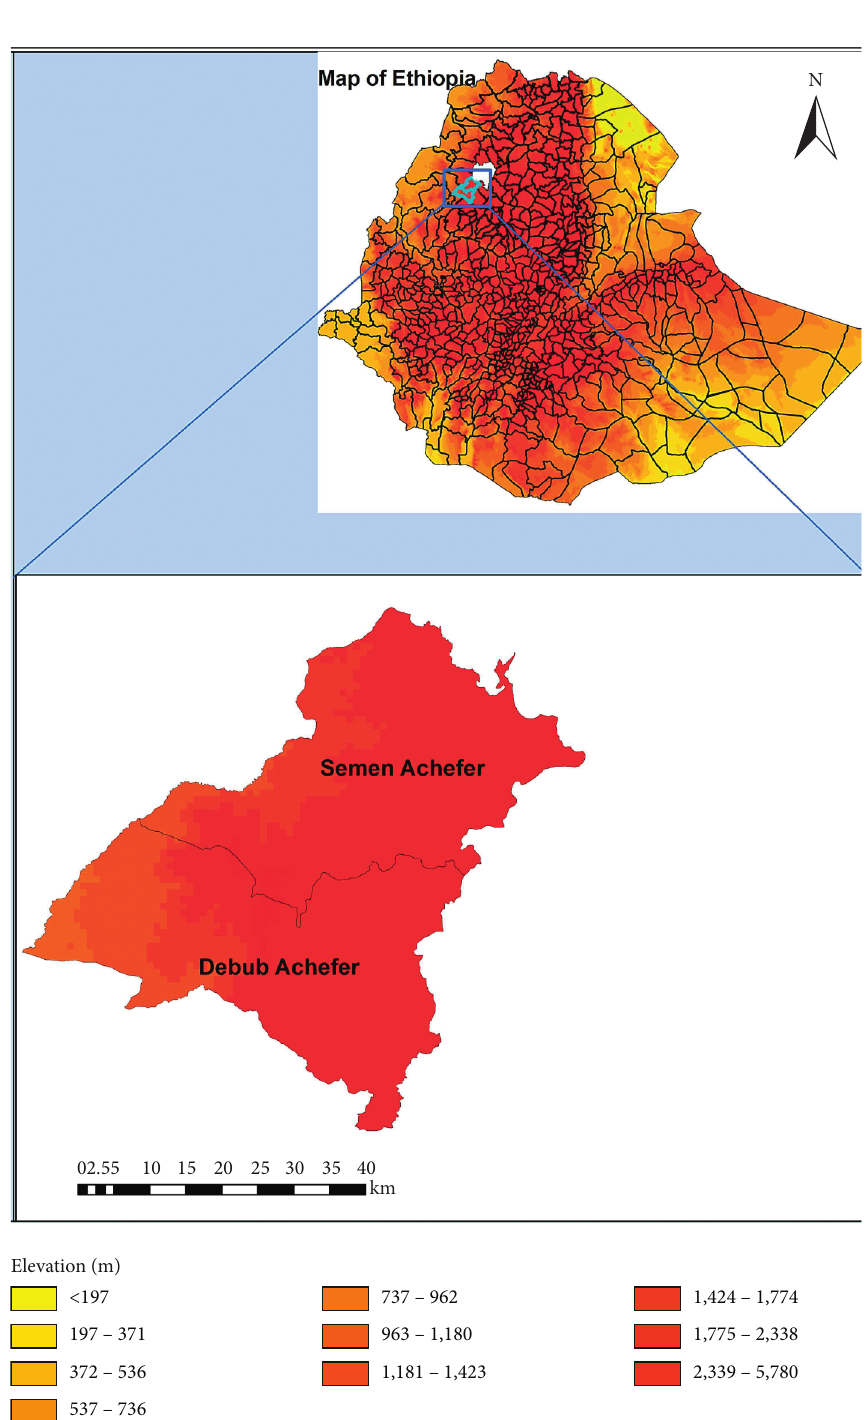
Figure 1: Map showing the geographical location of the study sites in Northwest